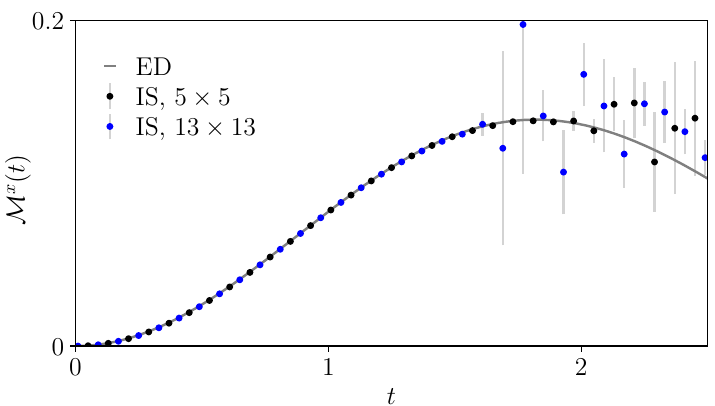
x in the 2D Ising Figure 3: Time evolution of the transverse magnetization M model (13) initialized in the |⇓〉 state and evolved using the Hamiltonian (13) with Γ = h = J / 4. For a 5 × 5 system we compare the results obtained by importance sampling (IS) to ED, finding good agreement up to the time when fluctuations be- come sizable. We also include data for a 13 × 13 system, for which no ED results are available. The IS results were respectively obtained from 5 × 10 4 and 10 5 indepen- dent trajectories. The error bars show the onset of large fluctuations at t ≈ 2.1 and t ≈ 1.7 for the chosen physical and computational